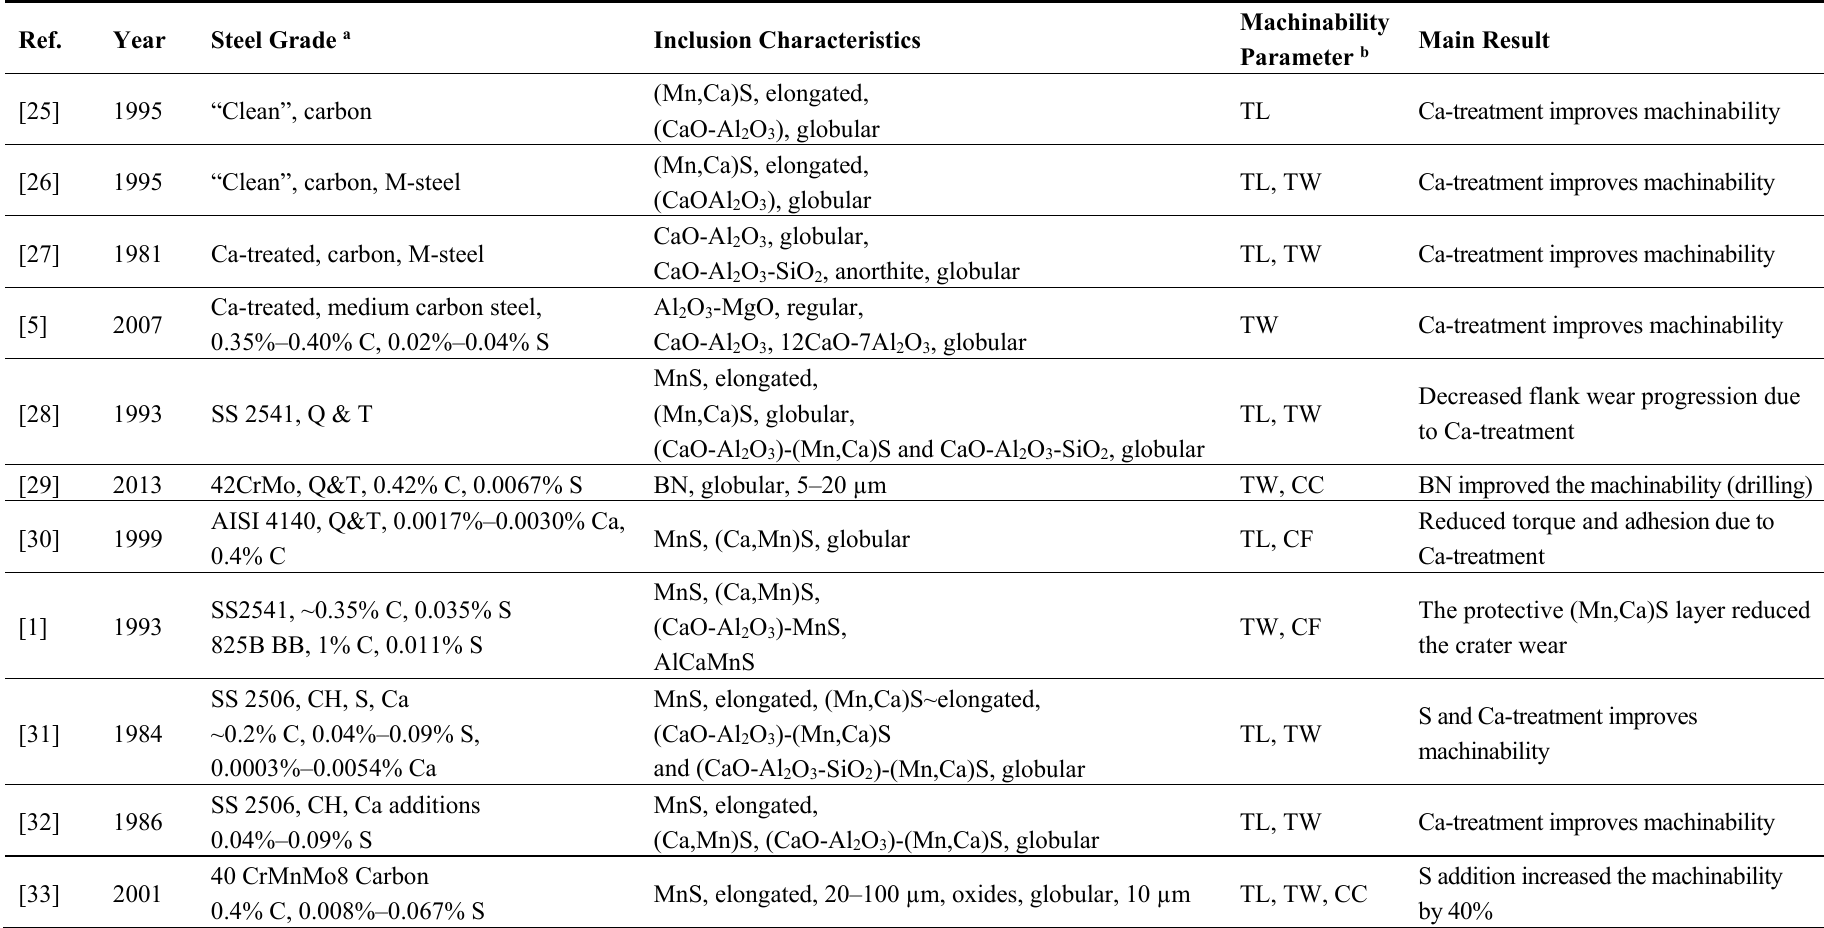
Table 4. Overview of published studies which considered the correlation of inclusion characteristics in different steel grades and their machinability